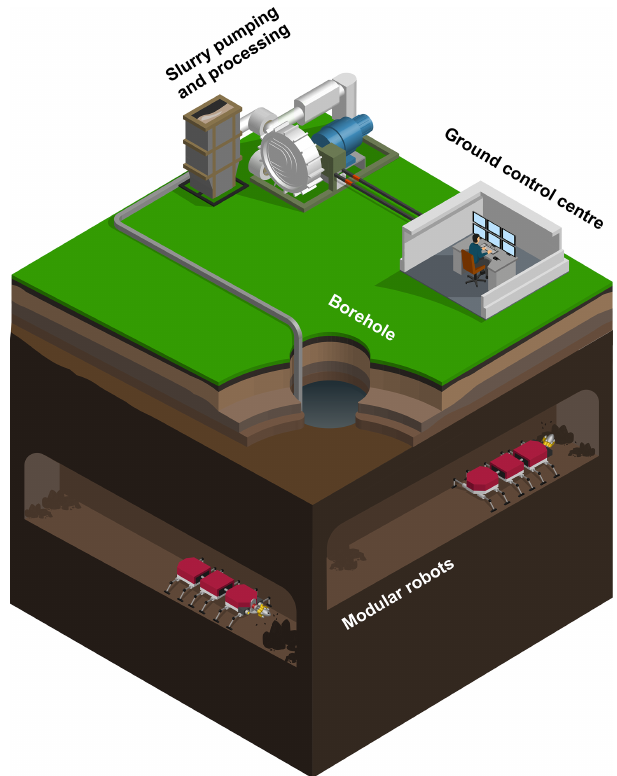
Figure 1. Representative figure of the ROBOMINERS concept showing the main